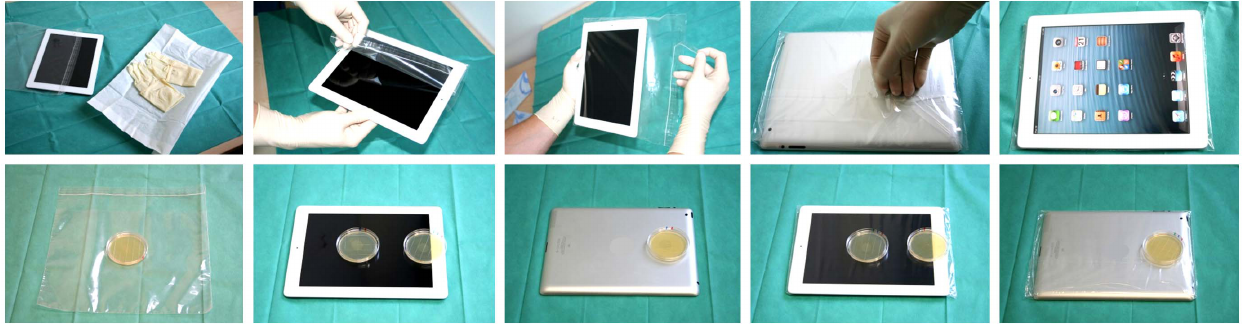
Figure 2. Illustration of the wrapping of the tablet and the sample collection. Upper row illustrates wrapping of the tablet computer using a sterile drape cloth and sterile gloves (Step 1). Lower row illustrates sample collection from an unused plastic bag, from the surface of the tablet and from the outside of a used plastic bag using Rodac plates (Step 1 and 4). The Rodac plates are positioned on the three defined regions of interest (ROIs; ROI A = central touchscreen, ROI B = home button and its adjacent area, ROI C = upper central